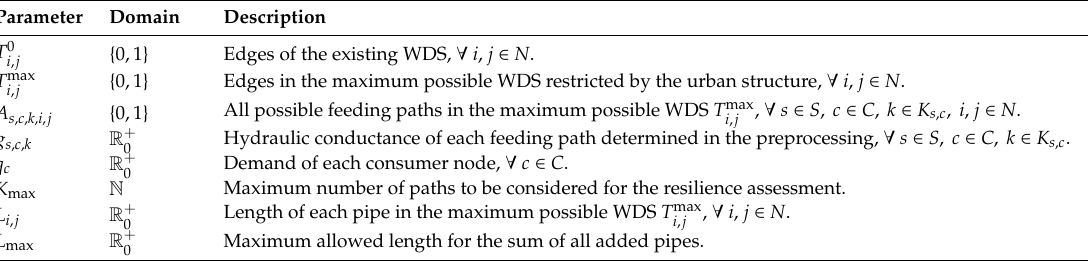
Table 3. Parameters of the optimization